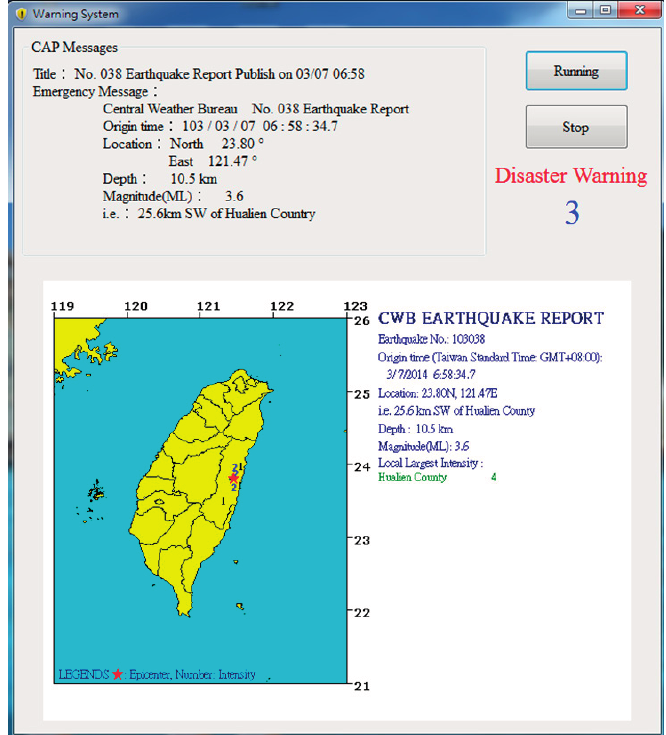
Figure 12. Human readable